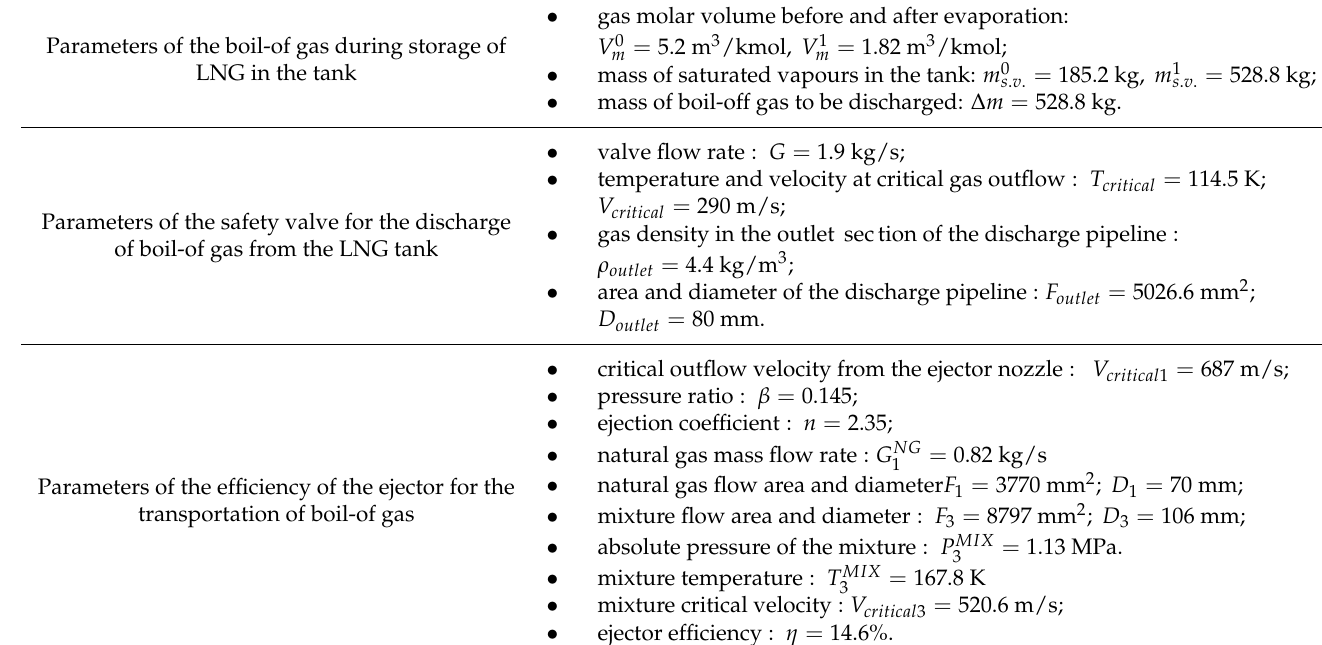
Parameters of the boil-of gas during storage of LNG in the